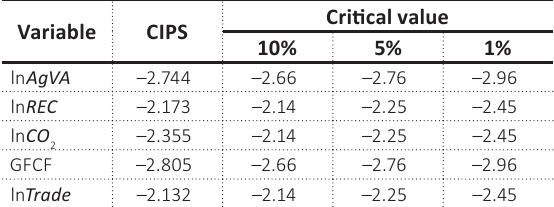
Table 4. Pesaran panel unit root test with